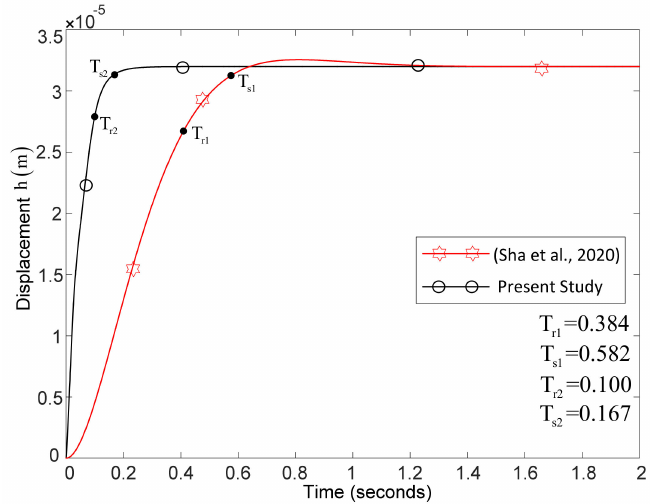
Figure 6. Comparison of tracking